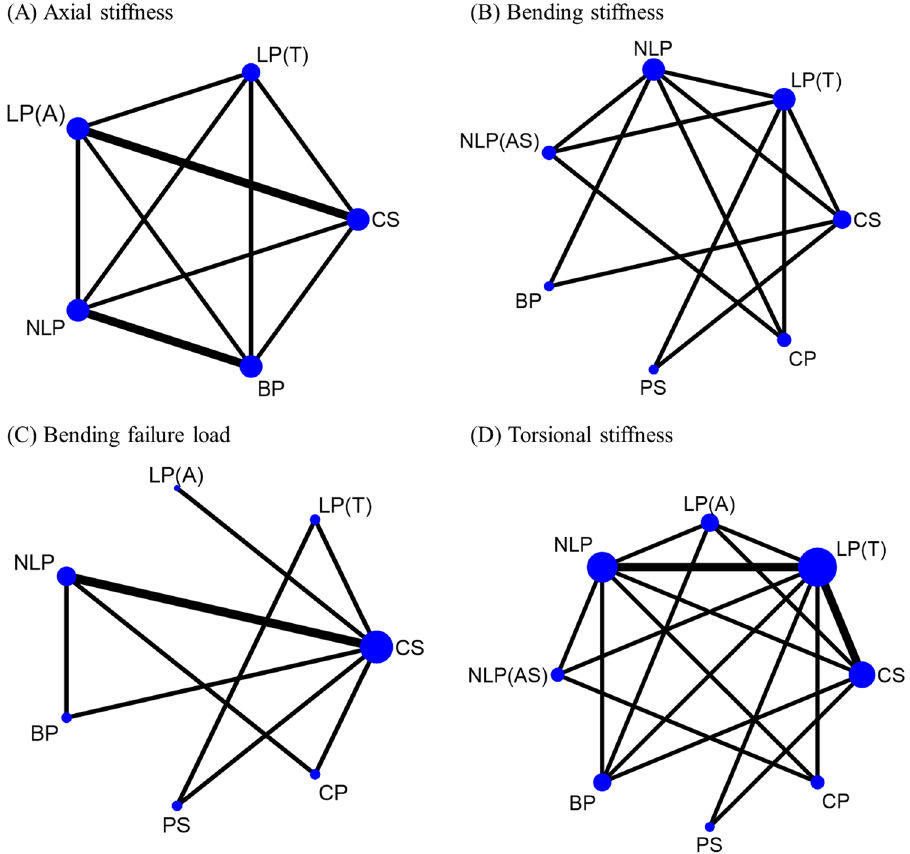
Figure 2. Network of the fixation method for radial neck fractures for ( A ) axial stiffness, ( B ) bending stiffness, ( C ) bending failure load, and ( D ) torsional stiffness. CS, Cross screw; LP(T), Locking plate (T plate); LP(A), Locking plate (anatomic plate); NLP, Nonlocking plate; NLP(AS), Nonlocking plate with augmented screw; BP, Blade plate; PS, Parallel screw; CP, Cross pin.